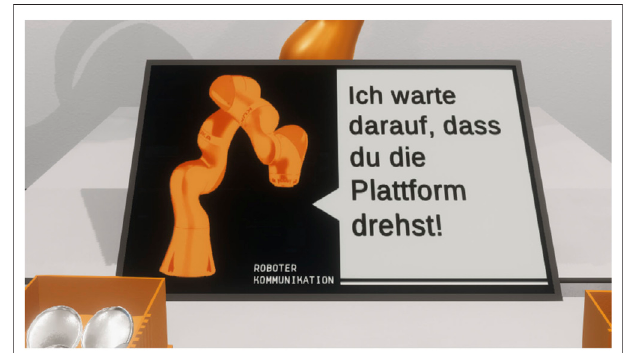
FIGURE6| Thetextpanelprovidedguidanceforthecurrenttaskandan explanation of the robot arms ’ behavior. The text was displayed within a speechbubblenexttoastylizedrepresentationoftherobotarmtostrengthen theaf fi liationofthestatementstotherobotarm.Thecommunicationwas formulatedinthe fi rst-personformtoevoketheperception oftherobotarmas a collaboration partner instead of a tool ( “ I ’ m waiting for you to turn the platform ”